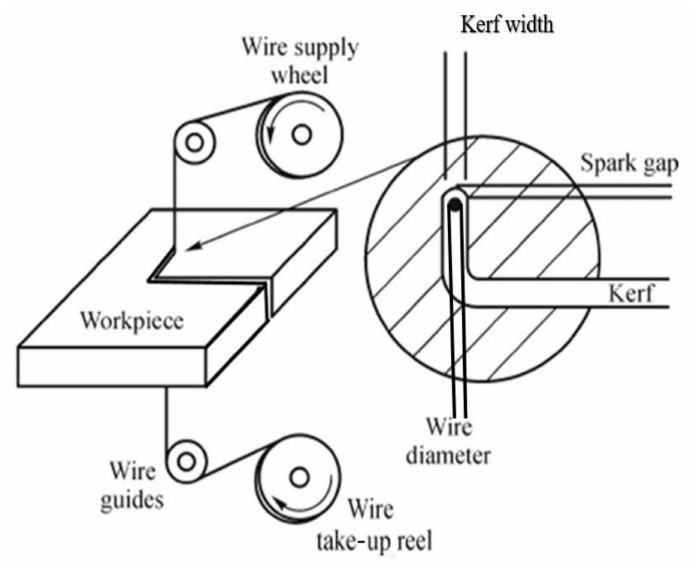
Figure 1. Wire electric discharge machining process